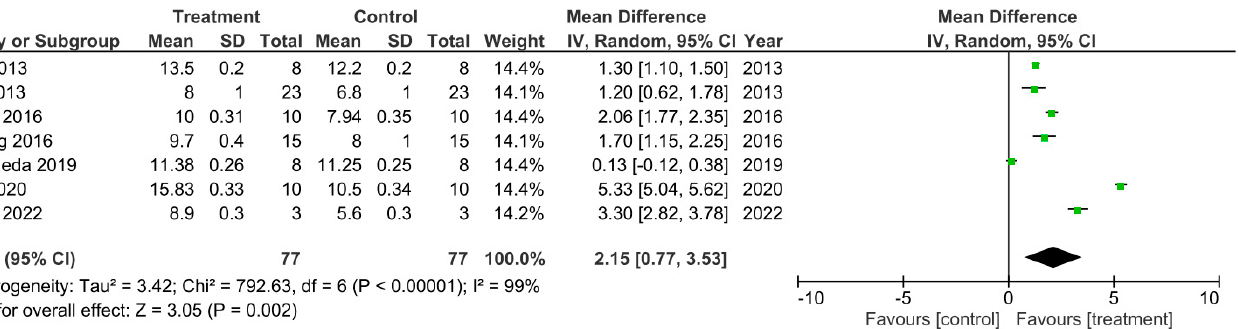
Figure 5. A meta-analysis for the effect of single treatments on the improvement of BBB scores ana- lyzed at 56 days after spinal cord injury in seven studies [15,18,26,29,40,47,50]. From the 32 studies that performed the BBB test, 9 of them analyzed a combined treatment for recovery of SCI [15,17,22,26–28,40,47,50]. These studies were sub-grouped for a meta-analysis of their final recorded BBB test score (Figure 6). There was a 99% het- erogeneity between these studies as calculated by the I 2 statistic. All of the studies, apart from the study by Mountney et al. [17] which investigated the use of combined chABC and sialidase treatment, had an increase in the BBB score in the treatment groups com- pared to controls, which therefore suggested improved functional recovery. However, only 7 of the studies were statistically significant [15,26–28,40,47,50]. The study by Bonilla et al. [22] did not demonstrate a statistically significant increase in the BBB score of the treatment group as indicated by the CI in the forest plot. Despite this, the overall effect of the treatments in all 9 of these studies was a statistically significant increase in BBB score